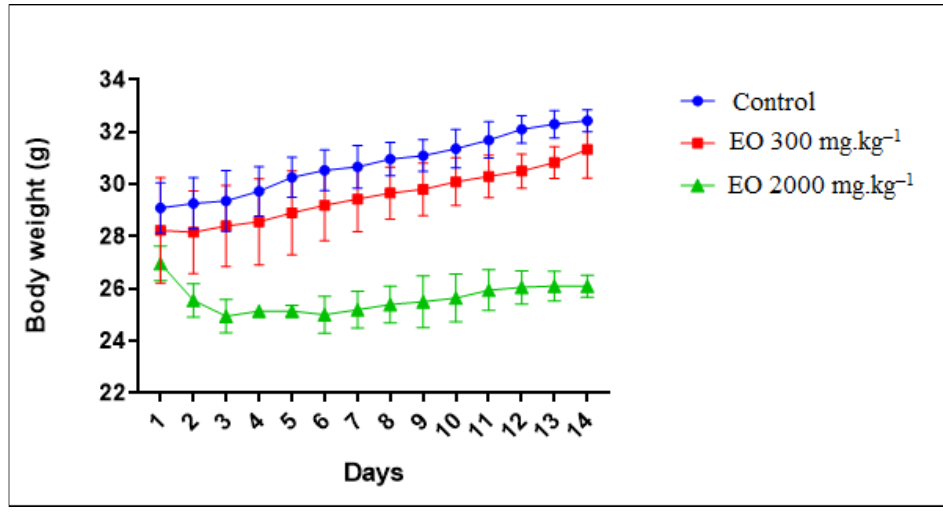
Figure 2. Evolution of the average weight of mice treated with orally administered Thymus lep- tobotrys Murb essential oil (EO) as a function of time in days. The data are represented as means ± SD.